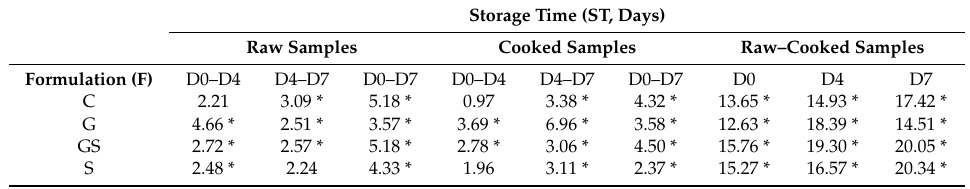
Table 3. Colour di ff erences ( ∆ E) within Formulation (F) between Storage Time (ST). Storage Time (ST, Days) Raw Samples Cooked Samples Raw–Cooked Samples